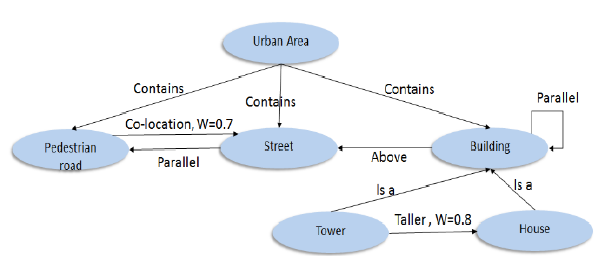
Figure 8 . An example of rules and restriction in an urban